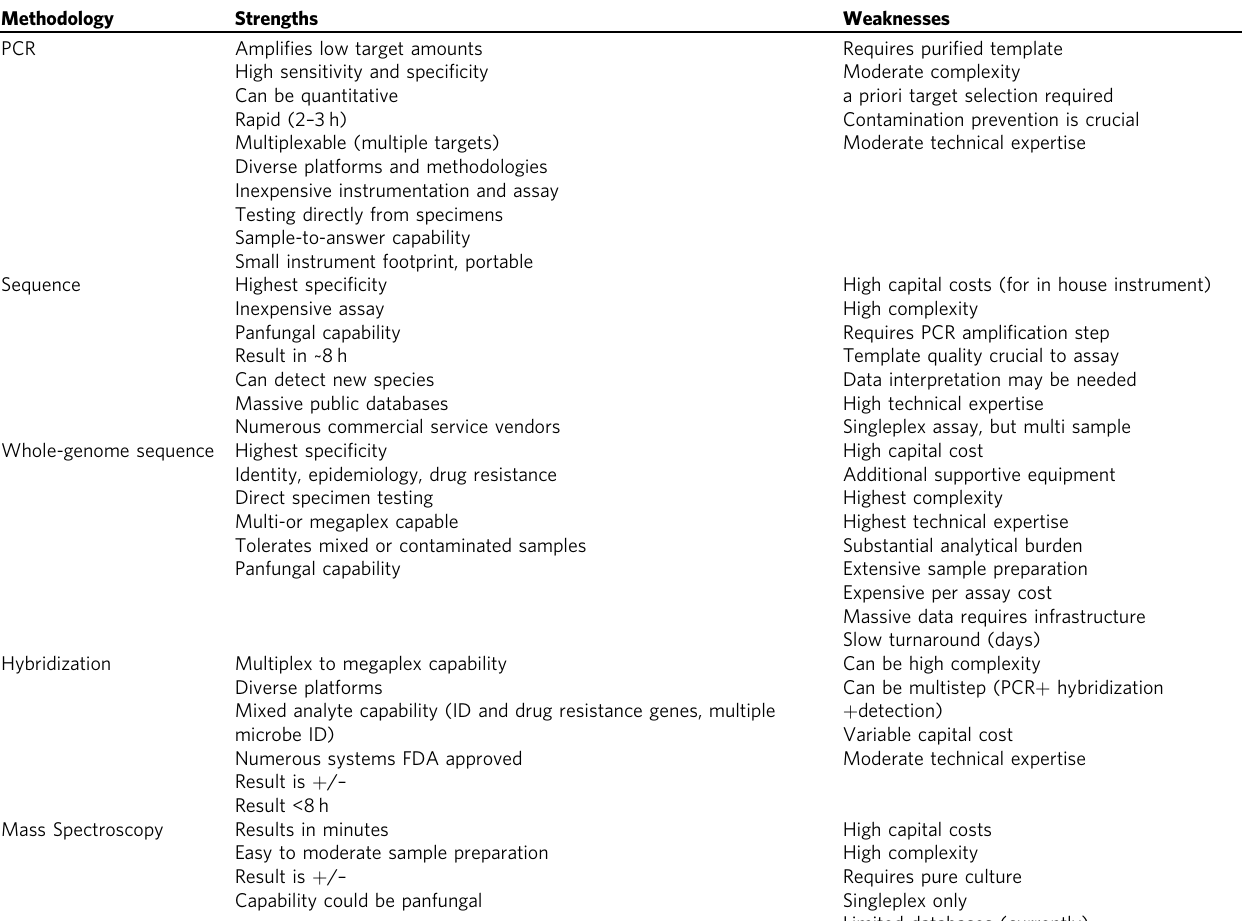
clinical samples compared to viral or bacterial loads 48 . This Table 2 Strengths and weaknesses of different platforms